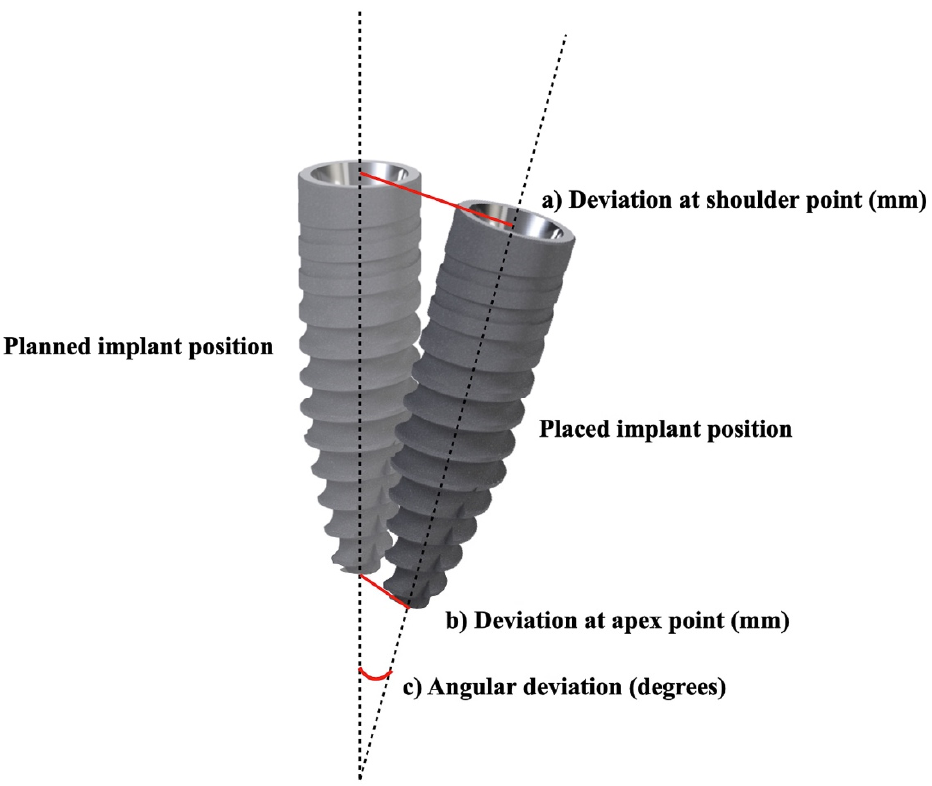
Figure 1. Deviation of placed implants coordinates from 3D planned implants coordinates (a: linear deviation at shoulder point; b: linear deviation at apex point; c: angular deviation).